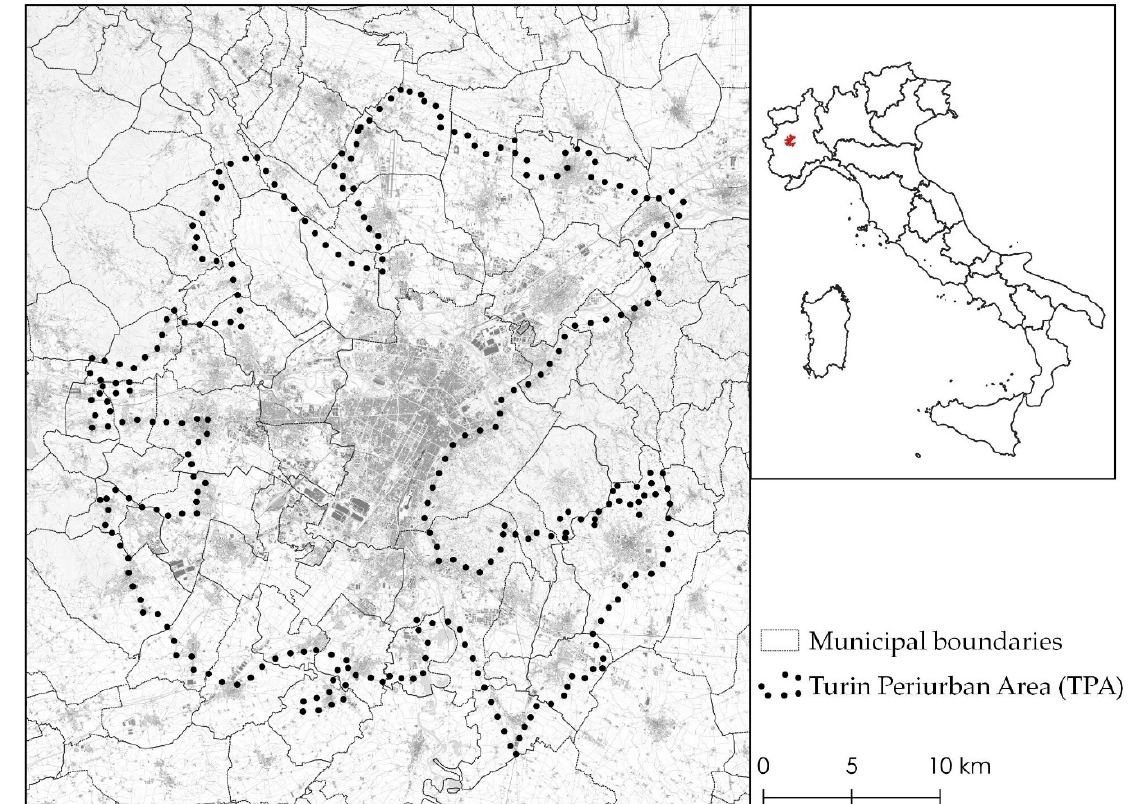
Figure 2. Map of the Turin peri-urban area (TPA).